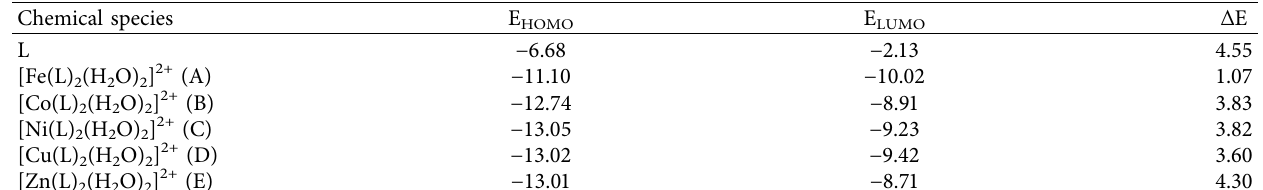
Table 4: Energies of HOMOs (E HOMO ), LUMOs (E LUMO ), and energy gap ( in the gas